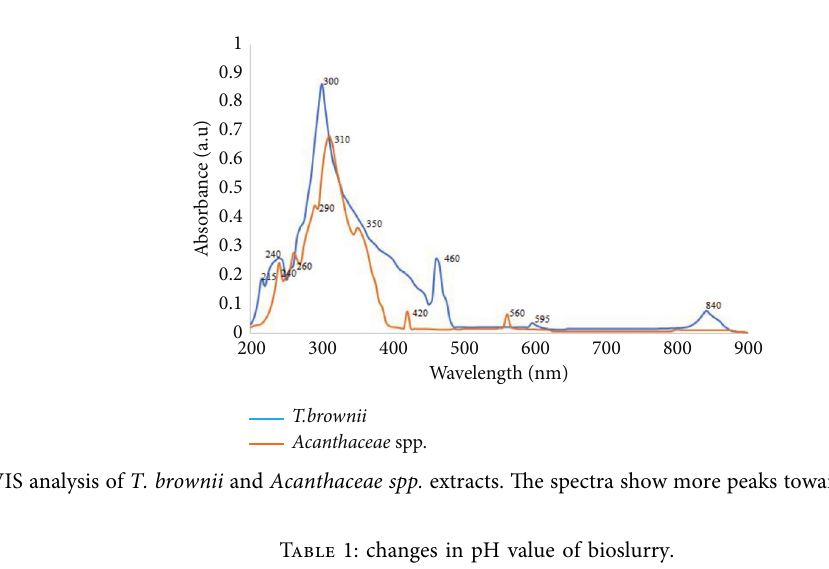
Figure 1: FT-IR spectra of T. brownii (red) and Acanthaceae spp. (blue) extracts. Though relatively similar, T. brownii extracts showed more functional group peaks.